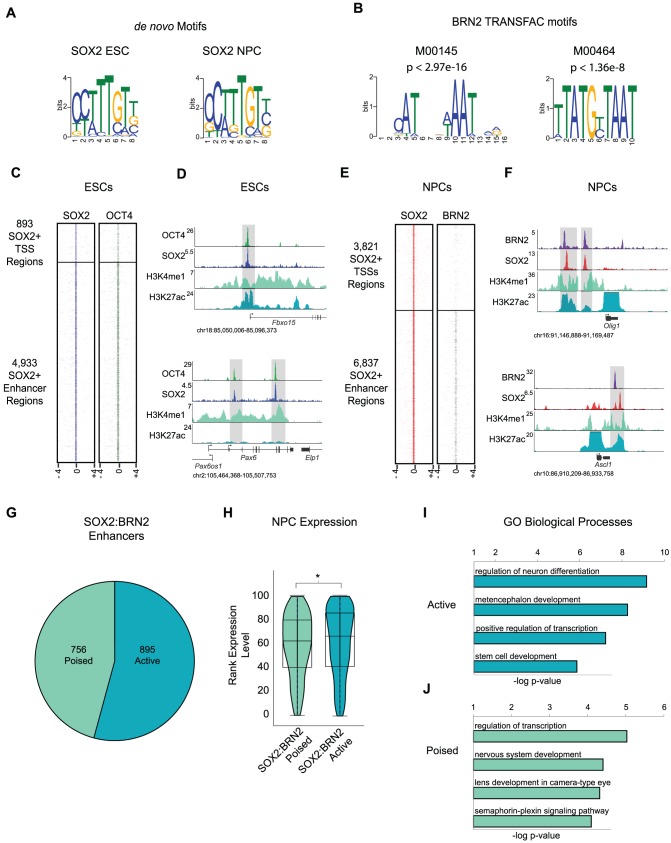
BRN2 co-occupies distal enhancers with SOX2 in NPCs.(A) de novo MEME motif analysis of SOX2 bound regions in ESCs and NPCs revealed canonical SOX2 motif. (B) TRANSFAC BRN2 motifs enriched in SOX2 target regions in NPCs. p-values represent significance of enrichment based on Mann-Whitney Wilcoxon ranked sum test with Benjamini-Hochberg multiple hypothesis testing correction. (C) Heat maps of SOX2 and OCT4 at SOX2 bound promoters and enhancers centered on peaks of SOX2 enrichment and extended 4 kb in each direction. (D) Gene plots showing SOX2, OCT4, H3K4me1, and H3K27Ac density at the Fbxo15 promoter and at poised enhancers of Pax6 in ESCs. y-axis corresponds to reads per million. Genomic positions reflect NCBI Mouse Genome Build 36 (mm8). Gray boxes indicate regions co-occupied by SOX2 and OCT4. (E) Heatmaps of SOX2 and BRN2 enrichment at SOX2-bound promoters and enhancers in NPCs centered on peaks of SOX2 enrichment and extended 4 kb in each direction. (F) Gene plots showing SOX2, BRN2, H3K4me1, and H3K27Ac density at Olig1 and Ascl1 loci in NPCs. y-axis corresponds to reads per million. Due to the high enrichment of H3K27Ac at active promoters, y-axis was cut off to show full dynamic range of enhancer-associated H3K27Ac density. Genomic positions reflect NCBI Mouse Genome Build 36 (mm8). Gray boxes indicate regions of SOX2-BRN2 co-occupancy. * indicates known enhancer. (G) Breakdown of number of SOX2-BRN2 target enhancers that are H3K4me1+, H3K27Ac− (poised) or H3K4me1+/−, H3K27Ac+ (active). (H) Box and Violin plots representing expression data from Affymetrix arrays of genes linked to poised and active SOX2-BRN2 target enhancers in NPCs. y-axis corresponds to percentile expression rank, * denotes p-value<0.01, Student's T-test, two tailed. (I, J) GREAT analysis of genes linked to poised and active SOX2-BRN2 target enhancers in NPCs.